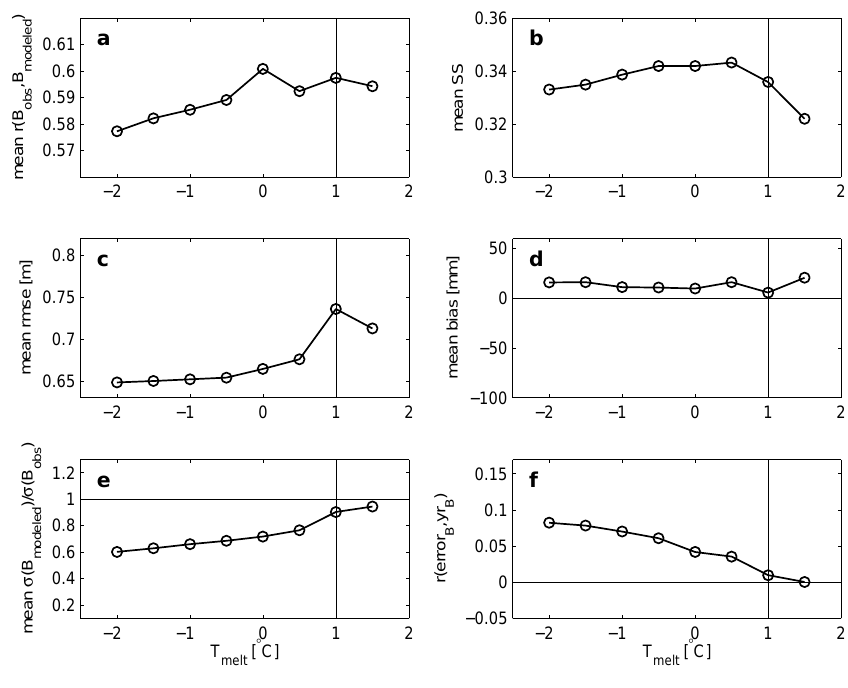
Fig. 7. As Fig. 4, but for the melt temperature threshold T melt .